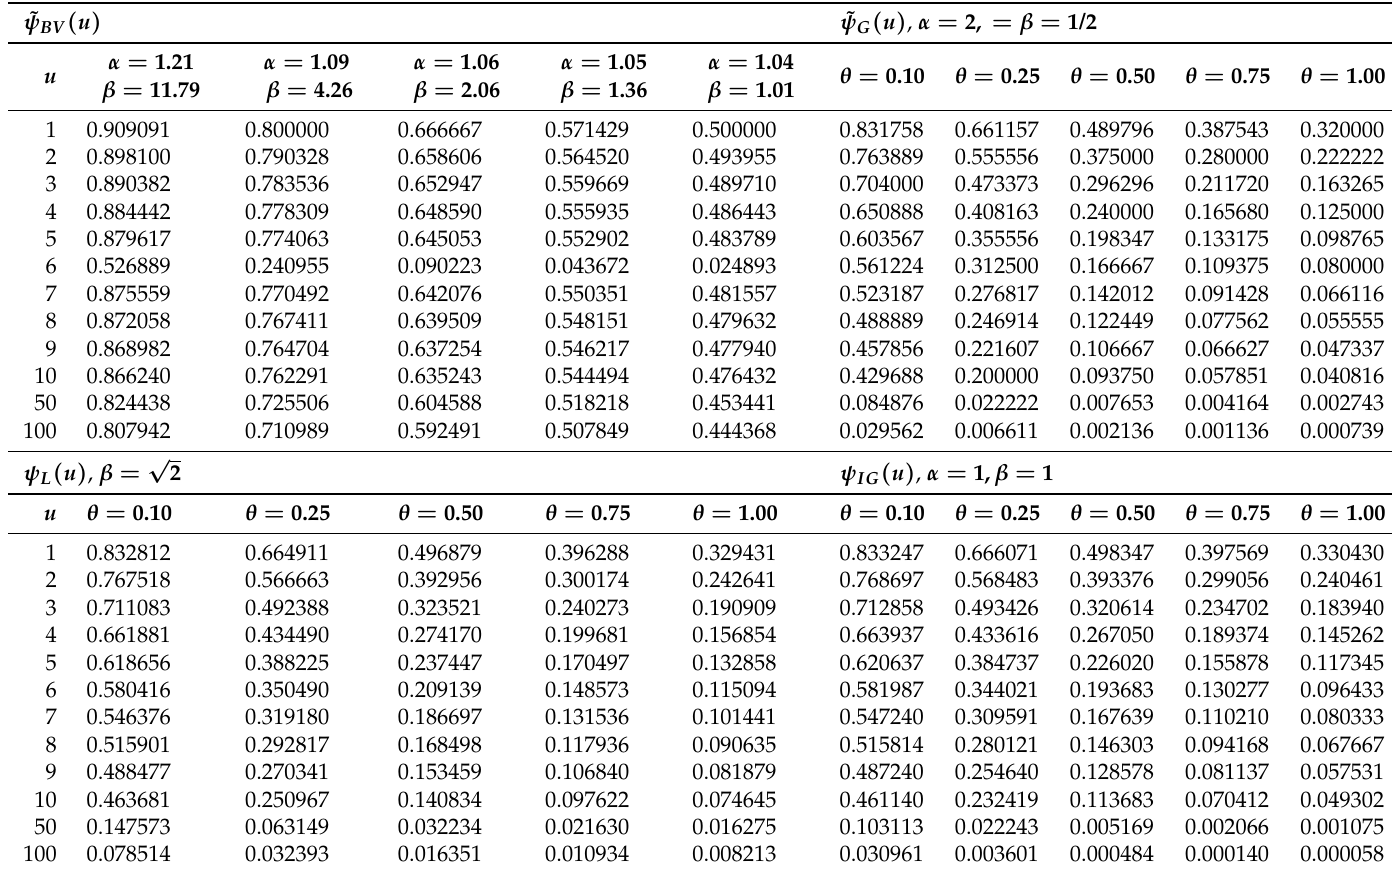
Table 3. Mixture ruin probabilities for the different models